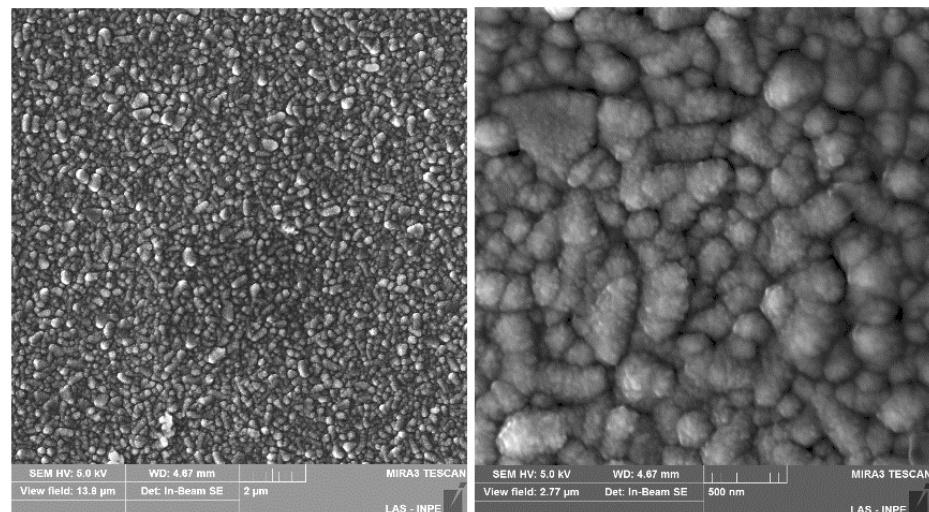
Figure 2. SEM micrographs of 225 nm thick porous TiO